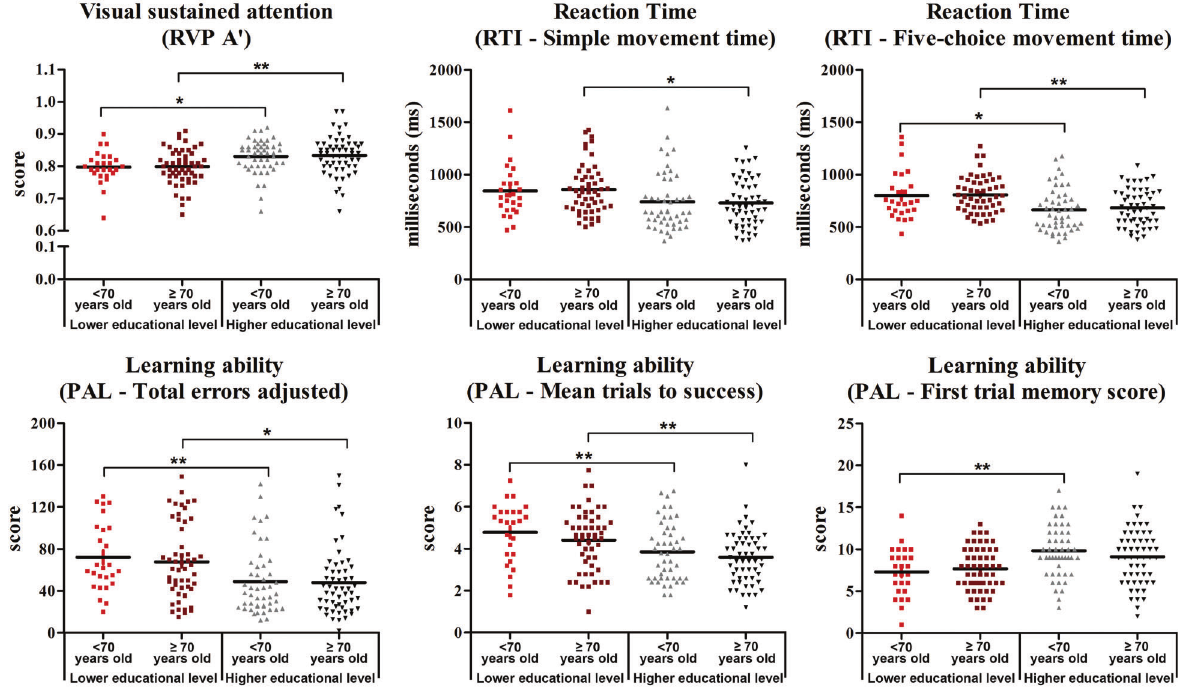
Figure 1. Graphical representations of cognitive performance. Results show the dispersal distribution of cognitive performance test scores in the lower education level o 70 years old group (red dots); lower education level X 70 years old group (dark red dots); higher education level o 70 years old group (gray triangles); and higher education level X 70 years old group (dark gray triangles). Black bars represent the mean score. RVP: Rapid Visual Information Processing; RTI: Reaction Time; PAL: Paired Associates Learning. *P o 0.05; **P o 0.01 (two-way ANOVA).